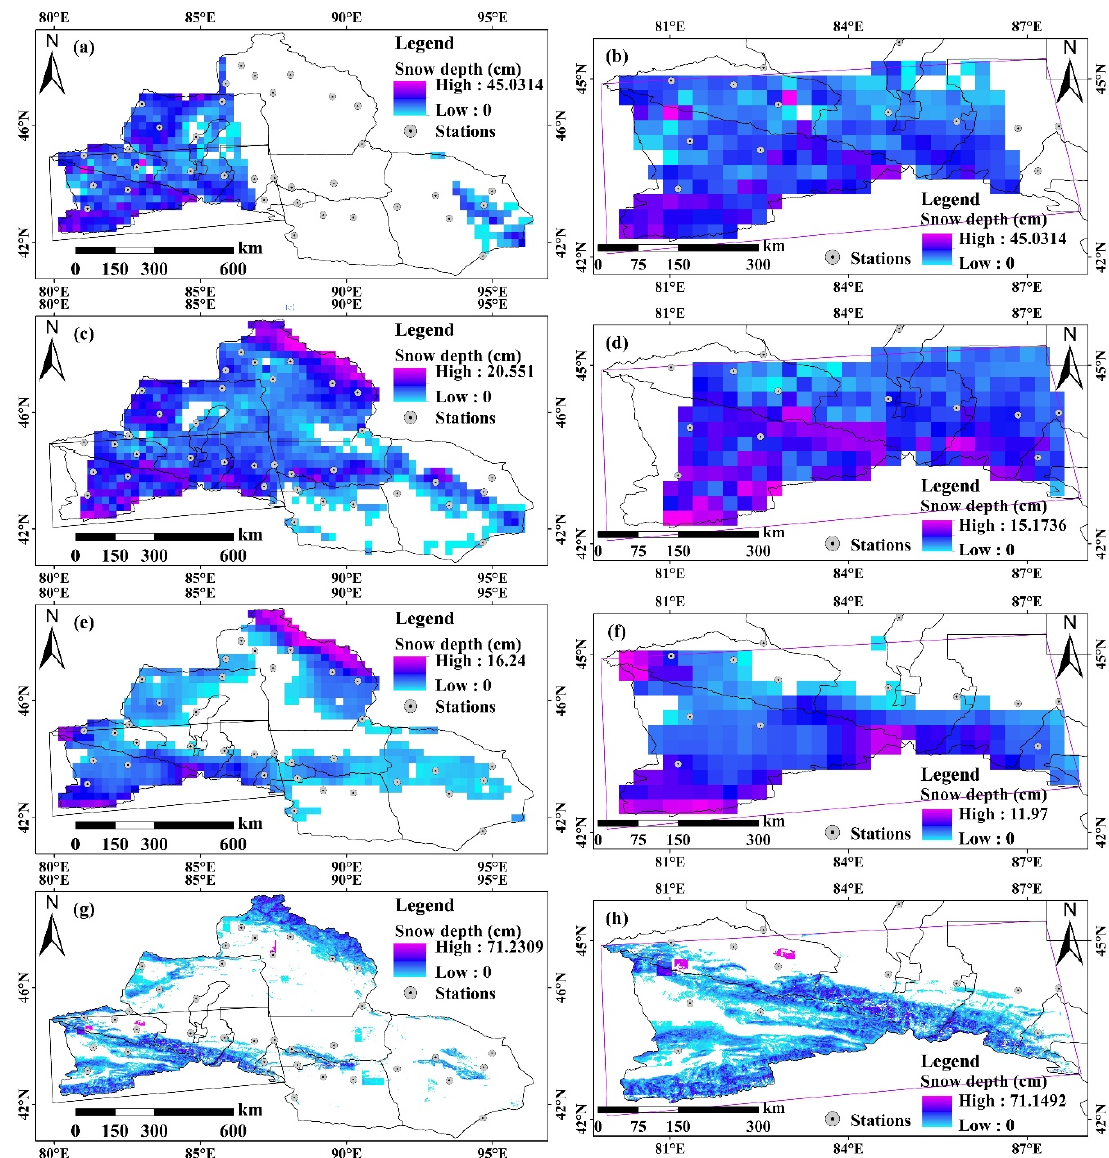
Figure 7. Snow depth mapping in NX on November 1, 2014: MWRI_A ( a ), MWRI_D ( c ), WESTDC_SD (Environmental and Ecological Science Data Center for West China Snow Depth) ( e ) and downscaled snow depth ( g ). corresponding enlarged maps of Tianshan and Ili River Valley are shown in ( b , d , f , h ).